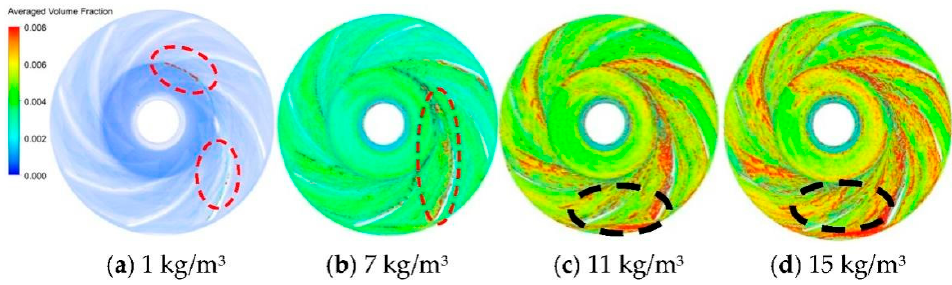
Figure 18. Distribution of solid volume fraction under different particle concentrations.